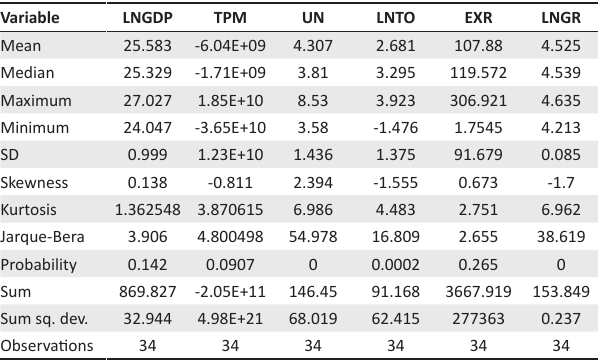
TABLE 1: Descriptive